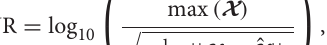
algorithm that solves the total variation